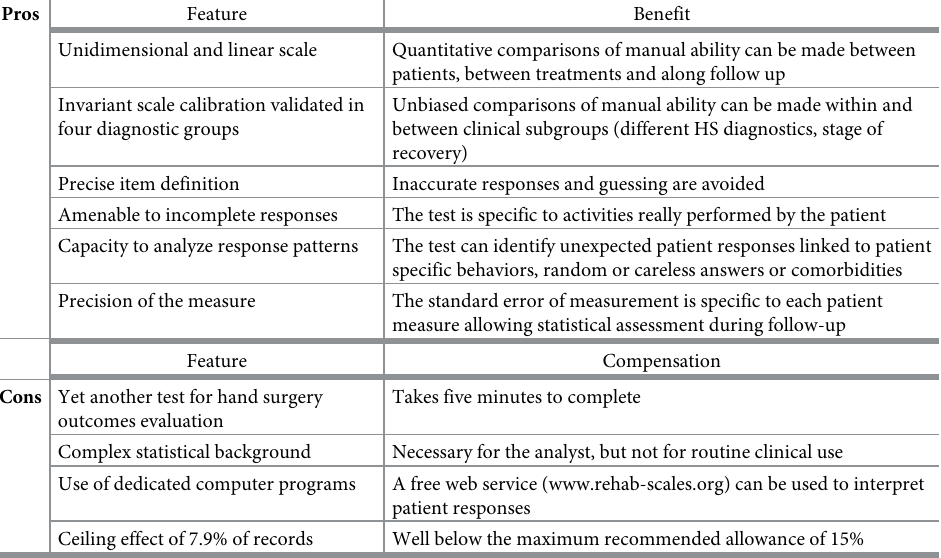
Table 4. Pros and cons of the